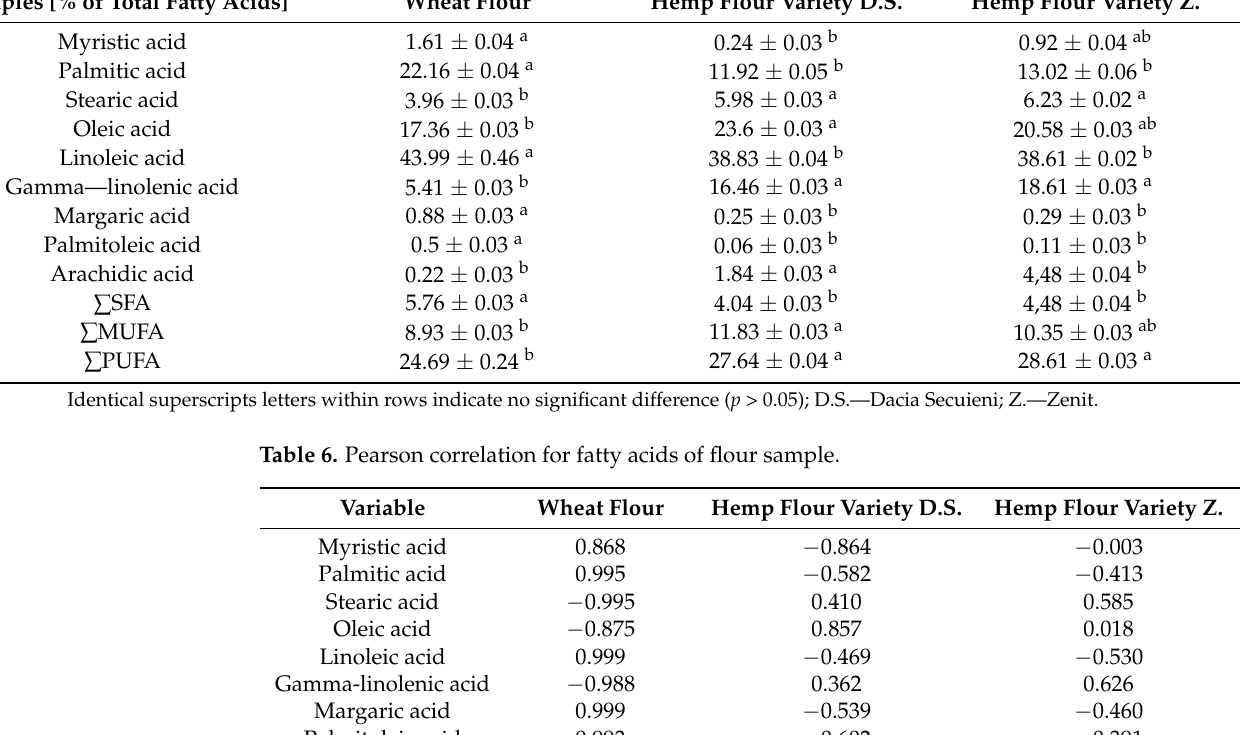
Table 5. The content of fatty acids of wheat flour and hemp flour. Wheat Flour Hemp Flour Variety D.S.